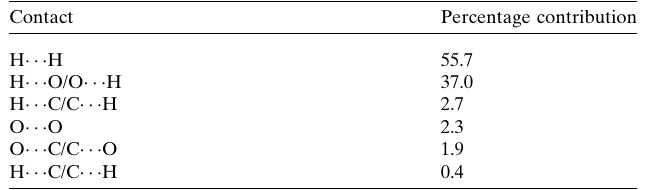
Table 2 Summary of short interatomic contacts (A˚ ) in (I) a . Contact Distance